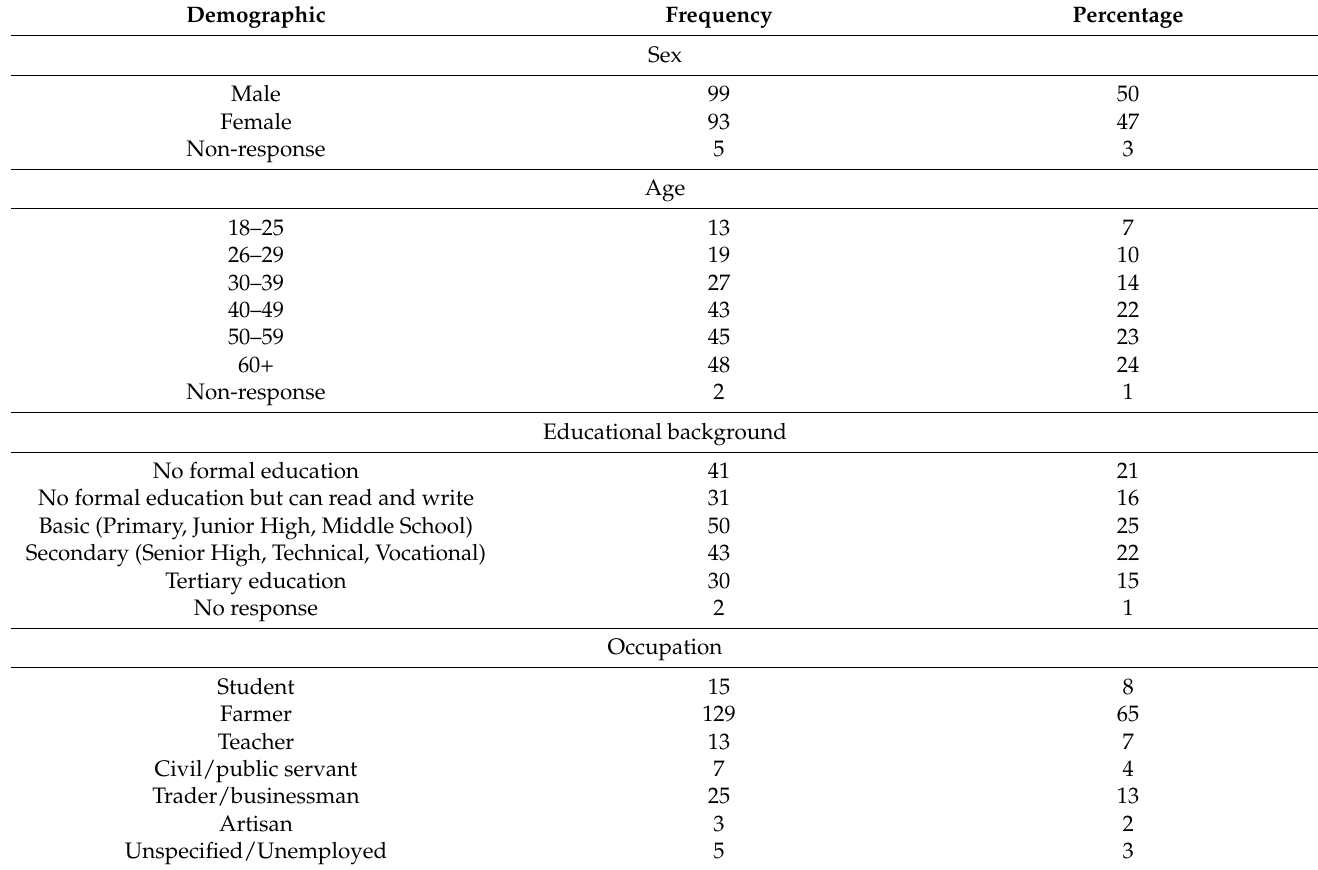
Table 1. Sociodemographic characteristics of